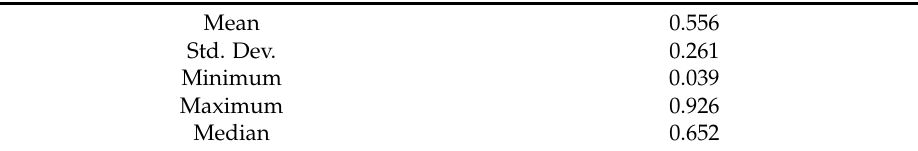
Table 4. Energy Efficiency Score.